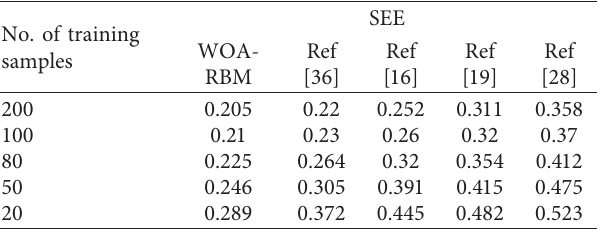
Figure 16: A comparison of energy consumption. Table 4: The effect of the number of training samples on the performance of the algorithm.